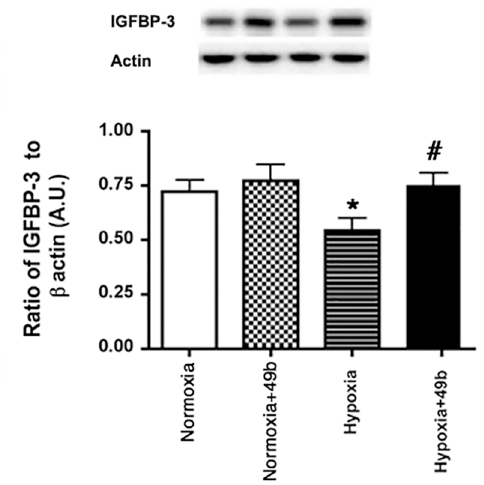
Fig 3. Protein levels of IGFBP-3 from retinal endothelial cells cultured in normoxia or hypoxia only and cells in each condition treated with Compound 49b. Hypoxia reduced IGFBP-3 levels, which were restored after treatment with Compound 49b. Data is mean ± SEM. * P < 0.05 vs. normoxia. # P < 0.05 vs. hypoxia. N = 4.